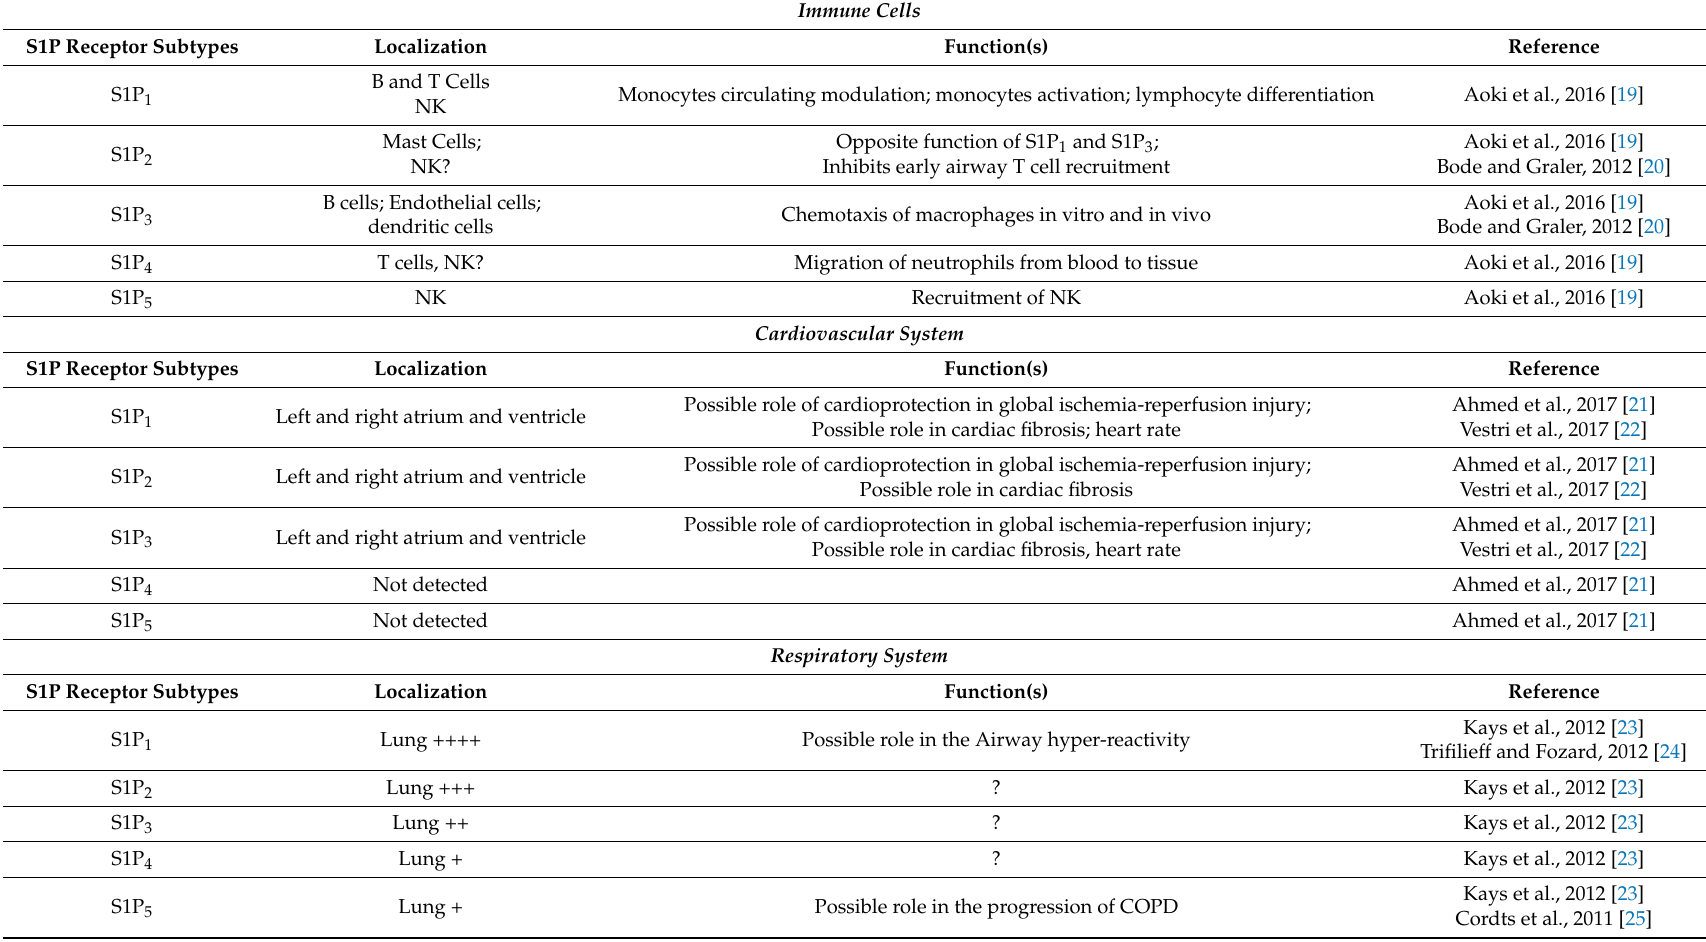
Table 1. S1P receptor subtypes and their roles in different